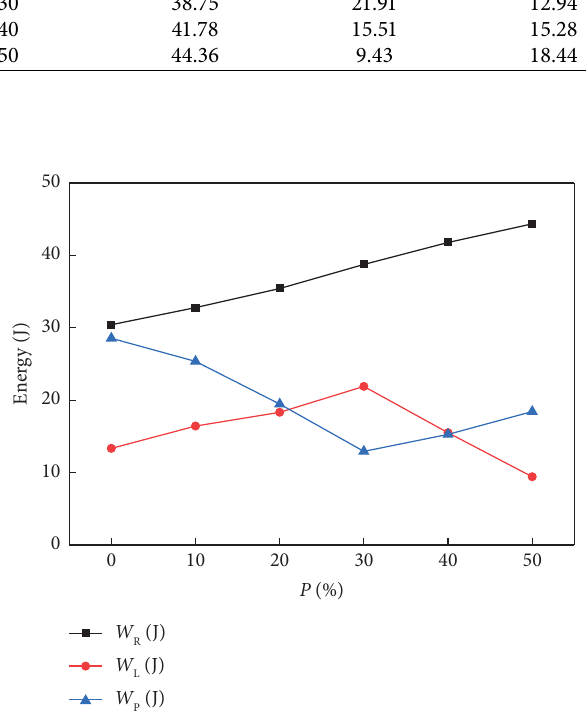
Figure 14: Change curve of each energy of concrete with fy ash content change.